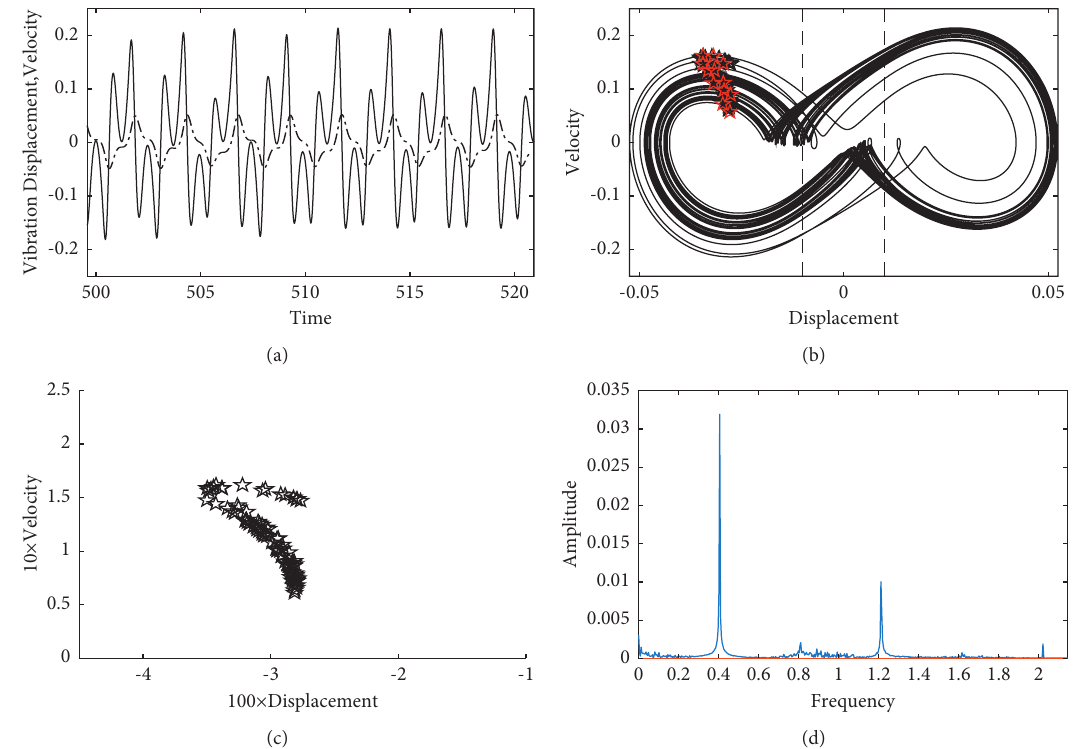
Figure 9: f � 0 . 405 Hz, chaotic motion. (a) Time history graph. (b) Phase diagram. (c) Poincar´e section. (d) Power spectral density diagram.